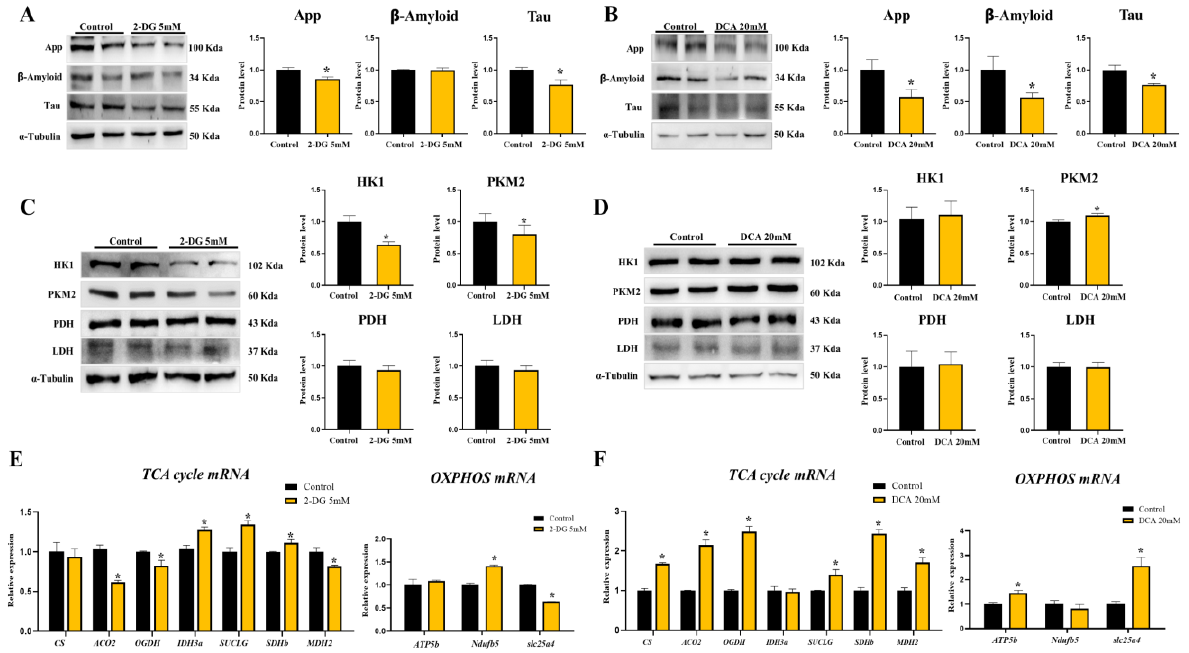
Figure 5. Glycolysis inhibition and TCA activation condition decrease neurodegenerative markers. ( A ) Western blot analysis and quantification of Western blot analysis and quantification of Alzheimer’s disease-related genes were evaluated in DBT cells of 2-Deoxy-d-glucose (2-DG) 5 mM-treated mice. Alpha-Tubulin was used as an internal control. ( B ) Western blot analysis and quantification of Western blot analysis and quantification of Alzheimer’s disease-related genes were evaluated in DBT cells of Dichloroacetate acid (DCA) 20 mM-treated mice. Alpha-Tubulin was used as an internal control. ( C ) Western blot analysis and quantification of glycolysis related genes were evaluated in DBT cells of 2-DG 5 mM-treated mice. Alpha-Tubulin was used as an internal control. ( D ) Western blot analysis and quantification of glycolysis related genes were evaluated in DBT cells of DCA 20 mM-treated mice. Alpha-Tubulin was used as an internal control. ( E ) TCA cycle and OXPHOS genes mRNA levels were measured by quantitative RT-PCR in DBT cells treated with 2-DG. RPLP0 was used as an internal control. ( F ) TCA cycle and OXPHOS genes mRNA levels were measured by quantitative RT-PCR in DBT cells treated with DCA. RPLP0 was used as an internal control. The values stand for means ± S.D. * p < 0.05 was compared to the groups indicated. All experiments were repeated at least 3 times.